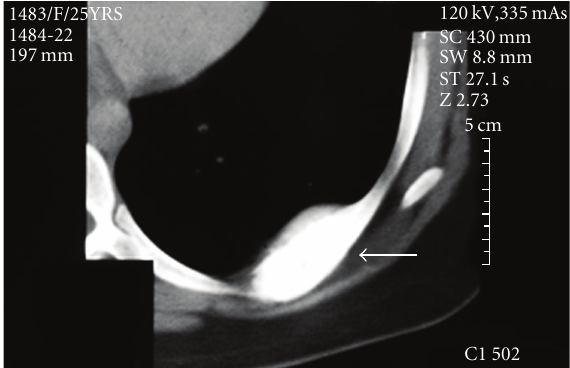
Figure 2: Computed tomography demonstrates a mass in the rib.